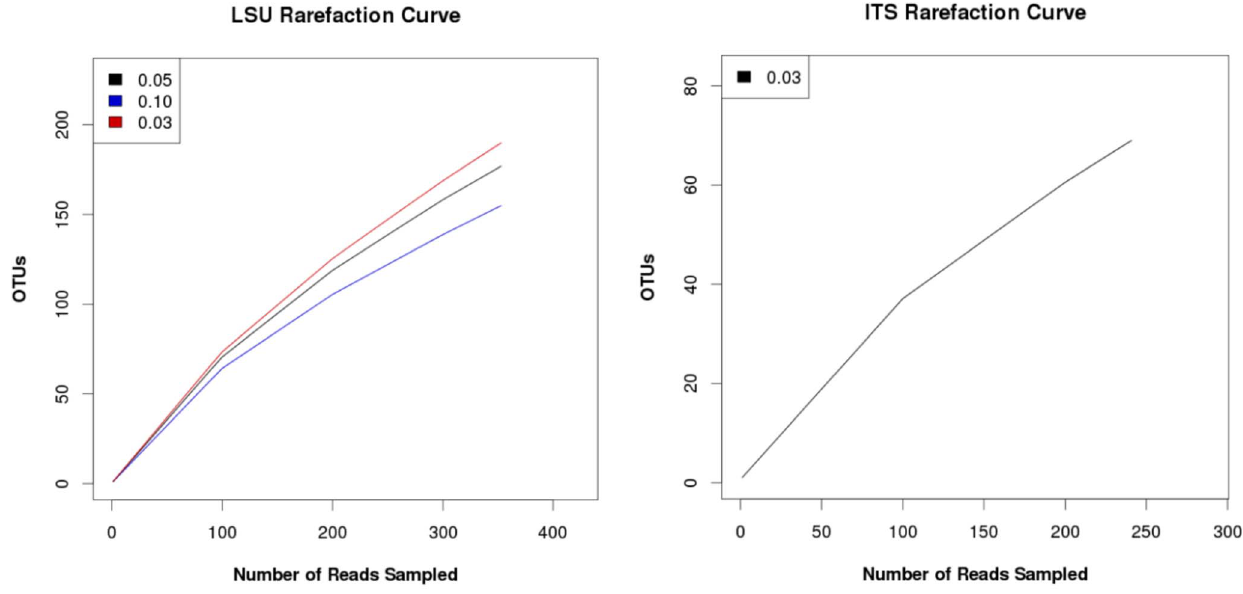
Figure 5. Rarefaction curves of estimated OTUs richness across bat WNS-afflicted niches environmental samples. A) LSU clones rarefaction curves analyses, cutoffs=0.03, 0.05, 0.10, respectively; B) ITS clones rarefaction curves analyses, cutoff=0.03.